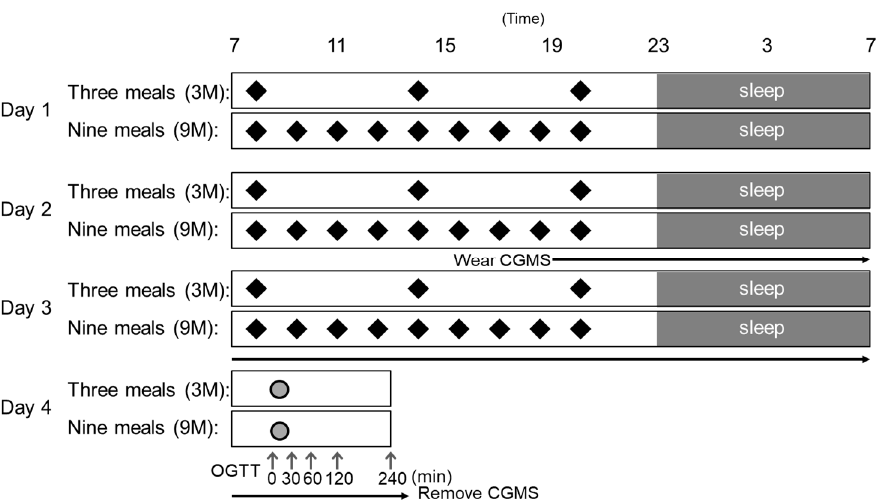
Figure 1. Schematic of the study design. During the trial period, subjects were allocated to receive 9 meals / day (9M) or 3 meals / day (3M) over the course of 3 days, with an oral glucose tolerance test (OGTT) conducted after the last day of the intervention period. The interventions were switched after at least a 2-week washout. In the 3M condition, the subjects were provided meals at 08:00, 14:00, and 20:00 on Days 1-3 of the intervention period. In the 9M condition, the same meals were divided into 9 meals, which were provided at 08:00, 09:30, 11:00, 12:30, 14:00, 15:30, 17:00, 18:30, and 20:00. The continuous glucose monitoring systems (CGMS) was worn by subjects starting at 18:00 on Day 2 up to 13:00 on Day 4. Approximately once every 6 h, the subjects performed calibrations using a self-monitoring blood glucose device. Subjects showered between 20:00 and 23:00 on Days 1 and 2, slept at 23:00, and woke up the next morning at 07:00. From Day 1 to Day 3, subjects drank water freely. On Day 4, subjects remained in a fasted state (no water, no food) after waking up, and the 75-g OGTT was performed. Gray area: sleep; black diamonds: meals; gray circles: intake of 75-g glucose solution; gray arrows: blood collection.